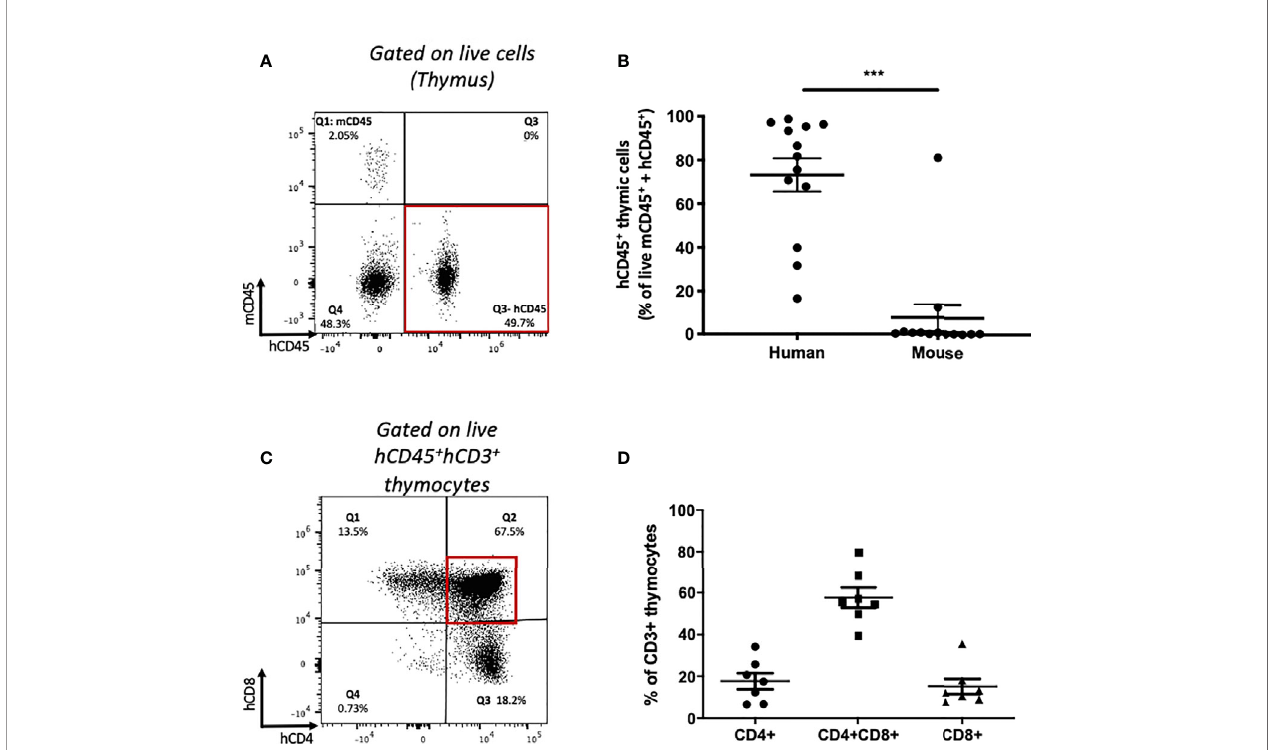
FIGURE 5 | Thymic human leucocyte engraftment and development of human thymocytes in HSPC-NBSGW mice. (A) Representative fl ow cytometric plot and (B) corresponding frequencies of human and mouse CD45 + cells (as percentage of mCD45 + hCD45 cells) in the thymi of HSPC-NBSGW mice 20-22 weeks after cell injection (50x10 3 dose shown). (C) Representative fl ow cytometric analysis and (D) corresponding frequencies of single-positive CD4 + , CD8 + and double-positive CD4 + CD8 + human thymocytes. Bars represent the mean ± SEM. Statistical signi fi cance was assessed using paired t tests